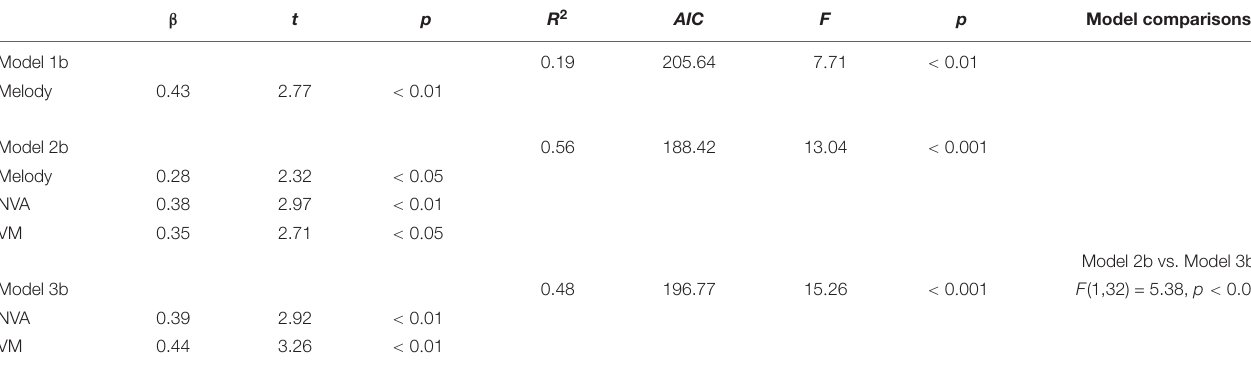
TABLE 6 | Summary and comparisons between Models 1b, 2b and 3b predicting language grammar.